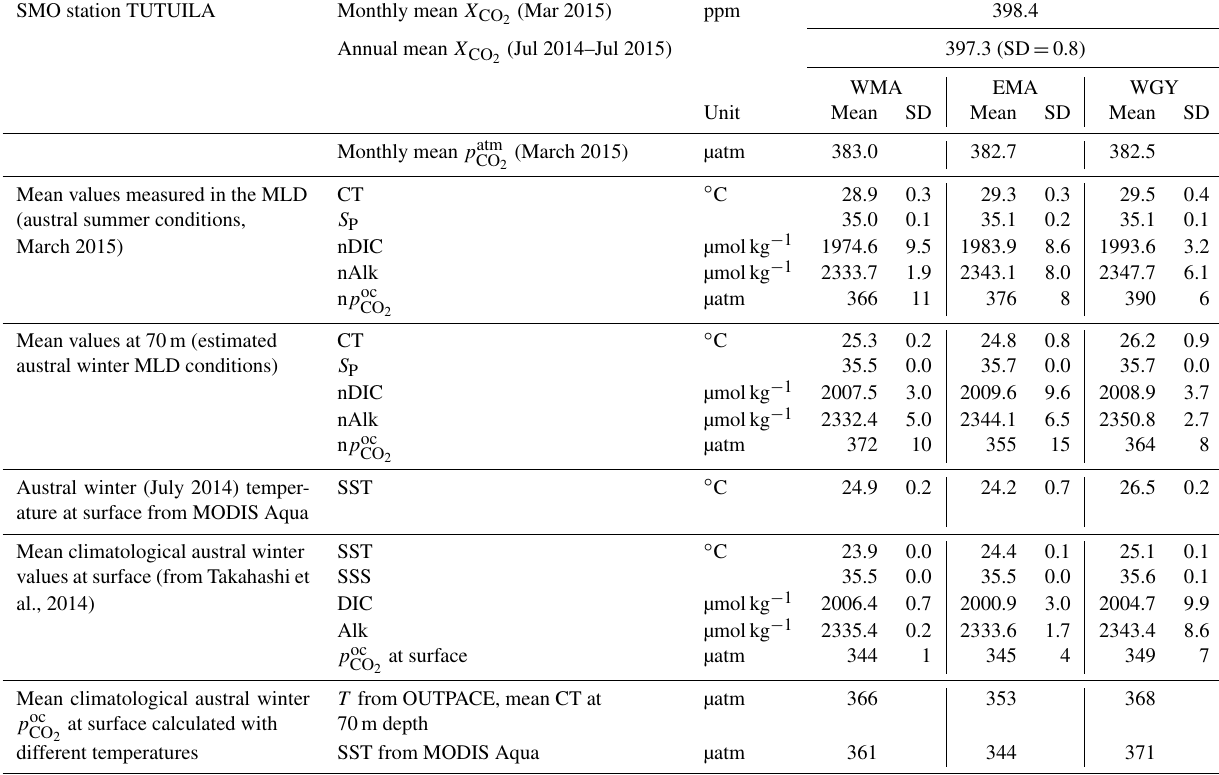
Table 5. Molar fraction of CO 2 ( X CO ) in dry air measured at SMO station Tutuila (American Samoa; lat. 14.247 ◦ S, long. 170.564 ◦ W; 2 ) . Mean values for the carbonate system, measured in the mixed ( p atm see Fig. 1; source: NOAA/ESRL) and derived atmospheric p CO CO 2 2 layer depth (MLD) during the OUTPACE cruise (summer conditions), measured at 70m depth (estimated winter conditions), and NDP-094 ) are given for different estimations of winter temperature ( p oc climatological data (Takahashi et al., 2014). Oceanic climatological p CO CO 2 2 (SST from NDP-094, mean T at 70m depth from OUTPACE, SST from MODIS Aqua). CT: conservative temperature, S p : practical salinity,